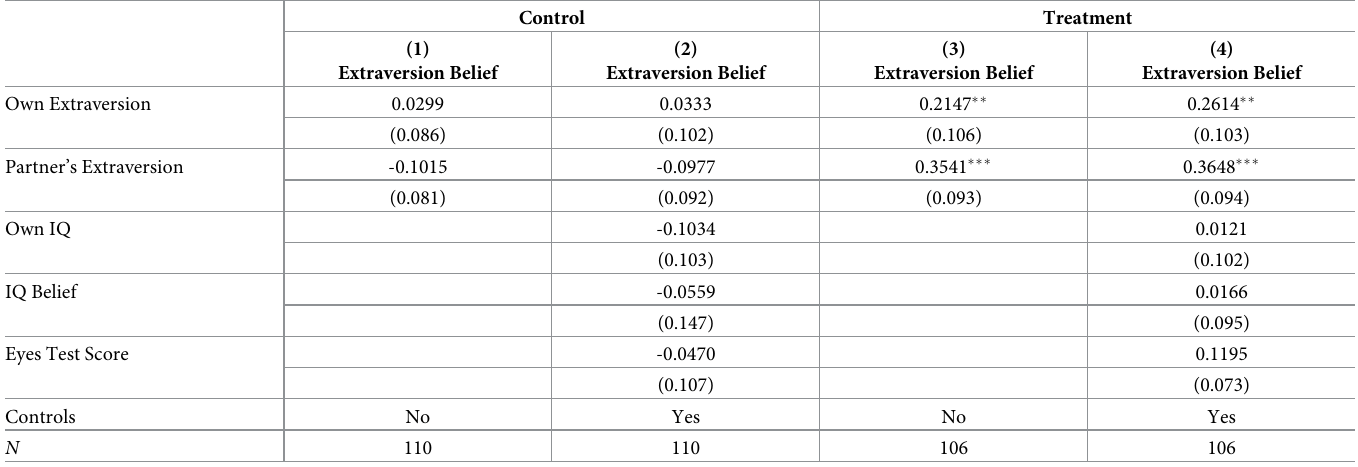
Table 6. First stage: Extraversion beliefs and public goods